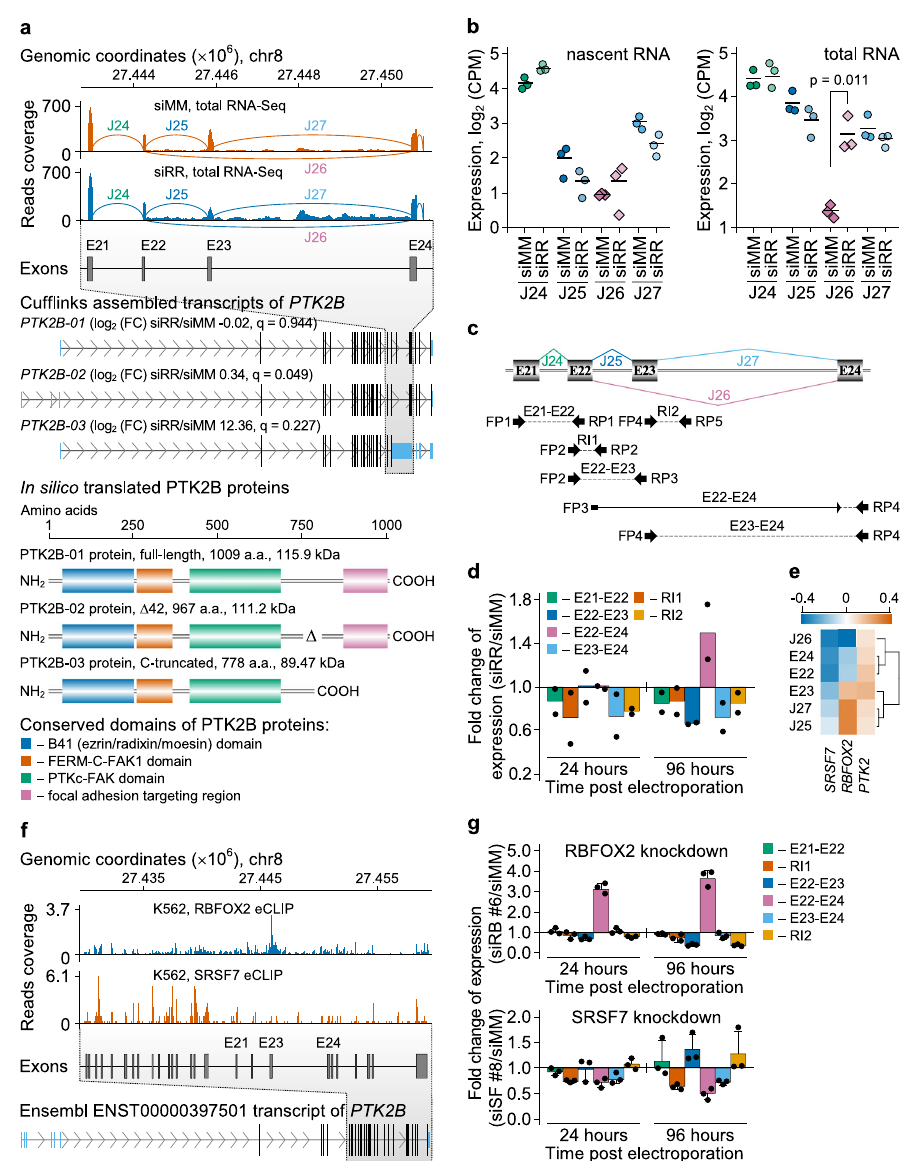
Fig. 10 RUNX1/RUNX1T1 controls alternative splicing of PTK2B transcripts in t(8;21)-positive leukemia cells. a Splicing graphs, representative Cuf fl inks assembled transcripts and in silico translated proteins of PTK2B gene. This panel is based on Kasumi-1 total RNA-Seq data. Exons and exon-exon junctions are designated by the letters E and J, respectively, and numbered. Differentially used junction J26 is highlighted in purple. For each transcript, Cuffdiff based log 2 fold changes in expression and respective q -values are indicated in parentheses. a denotes amino acids. b Strip charts demonstrating normalized expression of exon-exon junctions J24 to J27 in Kasumi-1 cells. Genomic location of junctions is shown in a . Horizontal lines are arithmetic means. P -value was calculated with two-sided Student ’ s t test. c and d qPCR-based validation of the differential splicing of PTK2B transcripts under two siRNA treatment conditions. Binding positions of primers and structure of the expected amplicons are shown in c . Bars in d represent mean of two independent qPCR experiments. e Pearson correlation heatmap demonstrating relationship between expression of the SRSF7 , RBFOX2 , or PTK2 genes and splicing events in the PTK2B gene. This map is based on TCGA-LAML dataset ( n = 173). f RBFOX2 and SRSF7 proteins bind PTK2B gene. This genome browser snapshot is based on ENCODE eCLIP data. g Effect of the siRNA-mediated knockdown of RBFOX2 and SRSF7 expression on splicing of the PTK2B gene in Kasumi-1 cells. Bars represent mean ± SD of three independent